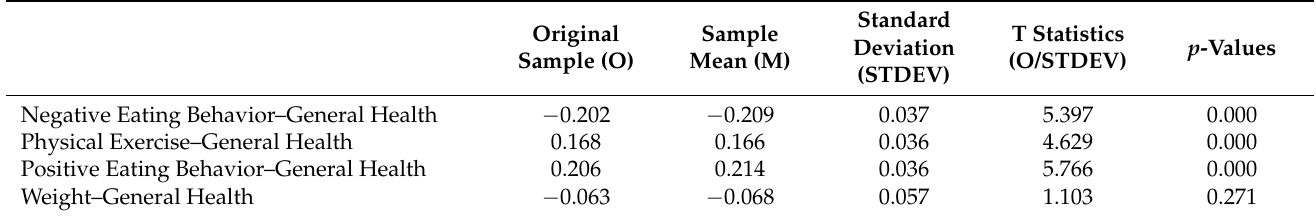
Table 5. Significance Testing Results of the Structural Model Path